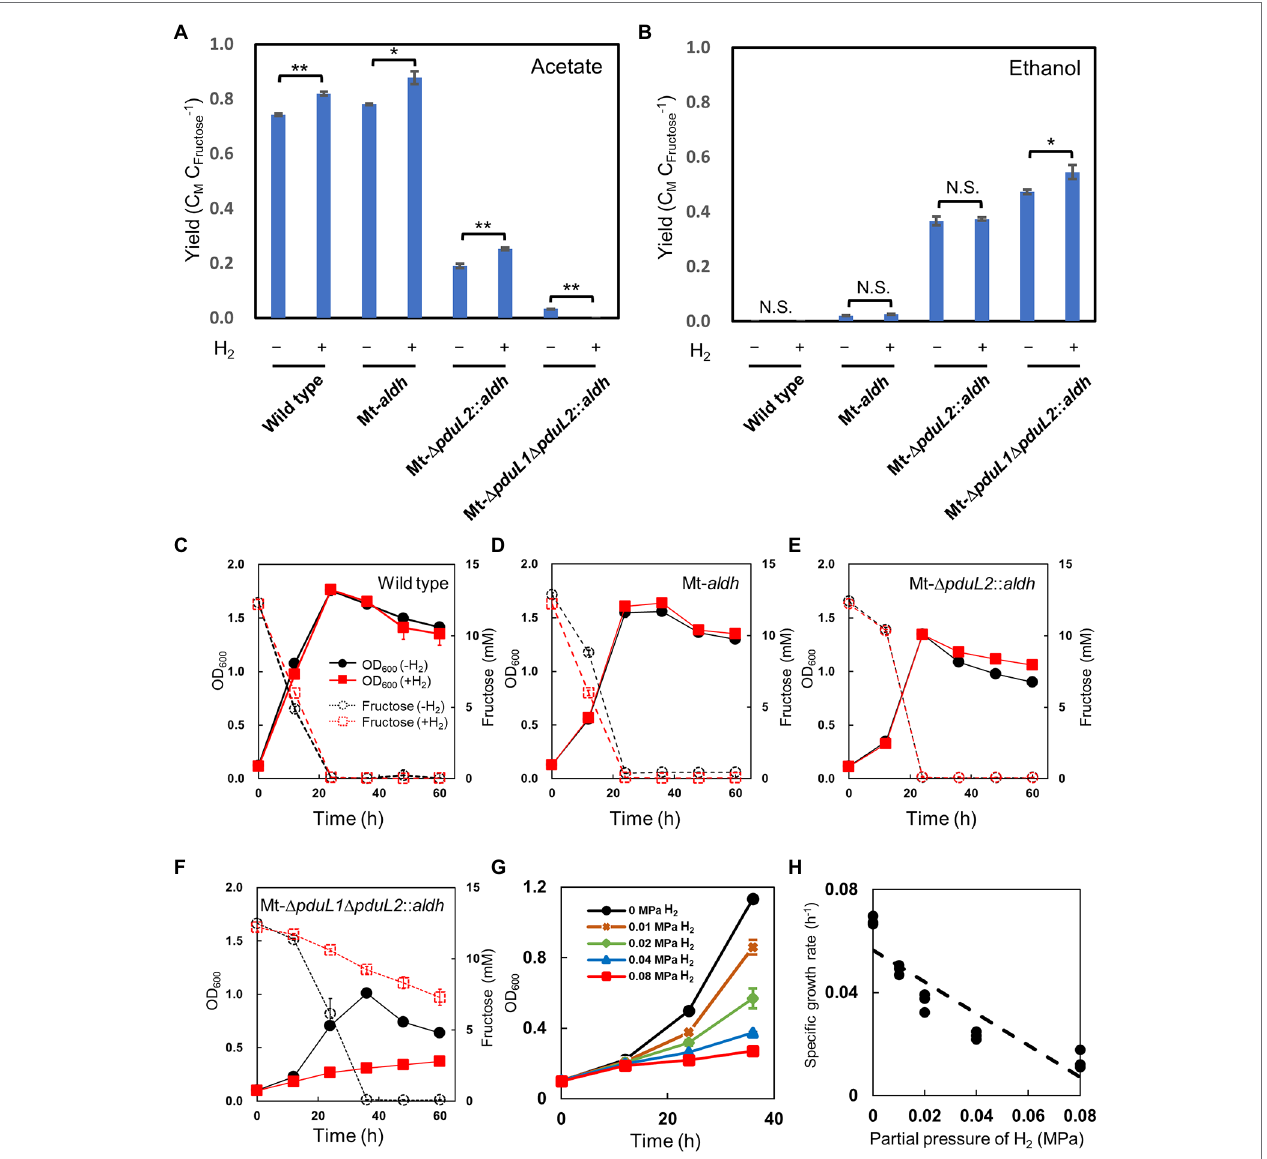
FIGURE 2 | Effect of H 2 supplementation on the wild-type strain and the engineered strains for ethanol production in mixotrophic conditions. (A,B) Product profiles shown as carbon molar yields (C M C Fructose − 1 ; C Metabolite C Fructose − 1 ). Fructose was used as the carbohydrate substrate. The amount of acetate and ethanol production was compared with and without supplementation of H 2 (0.08 MPa partial pressure, 40% in the headspace) after 60 h when all the supplied fructose was consumed in the no H 2 -supplied condition. t -test was performed to evaluate the significance. N.S., not significant; value of * p <0.05; value of ** p <0.01. (C-F) Profiles for cell growth and fructose consumption. The culture was same as in (A,B) . Cell density was shown as OD 600 (optical density at 600 nm) by solid lines. Fructose concentration was shown by dotted lines. Black, no H 2 -supplied condition; red, H 2 -supplied condition. (G) Growth profiles of the Mt- Δ pduL1 Δ pduL2 :: aldh strain with various H 2 partial pressures. The profiles of the exponential phase were compared. The standard deviation (SD) of three biological replicates is shown by error bars. Some error bars are smaller than the symbols. (H) Specific growth rate plotted against H 2 partial pressure. All data shown were obtained in the culture for (G)